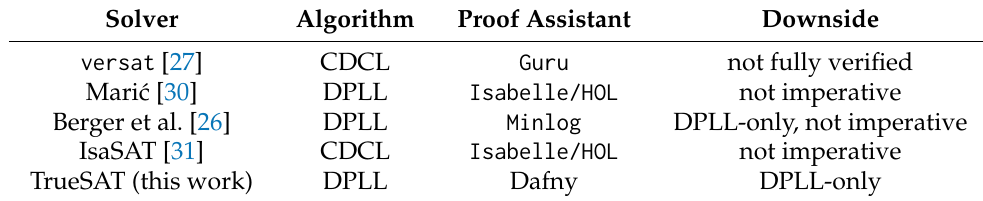
Table 1. Summary of existing verified SAT